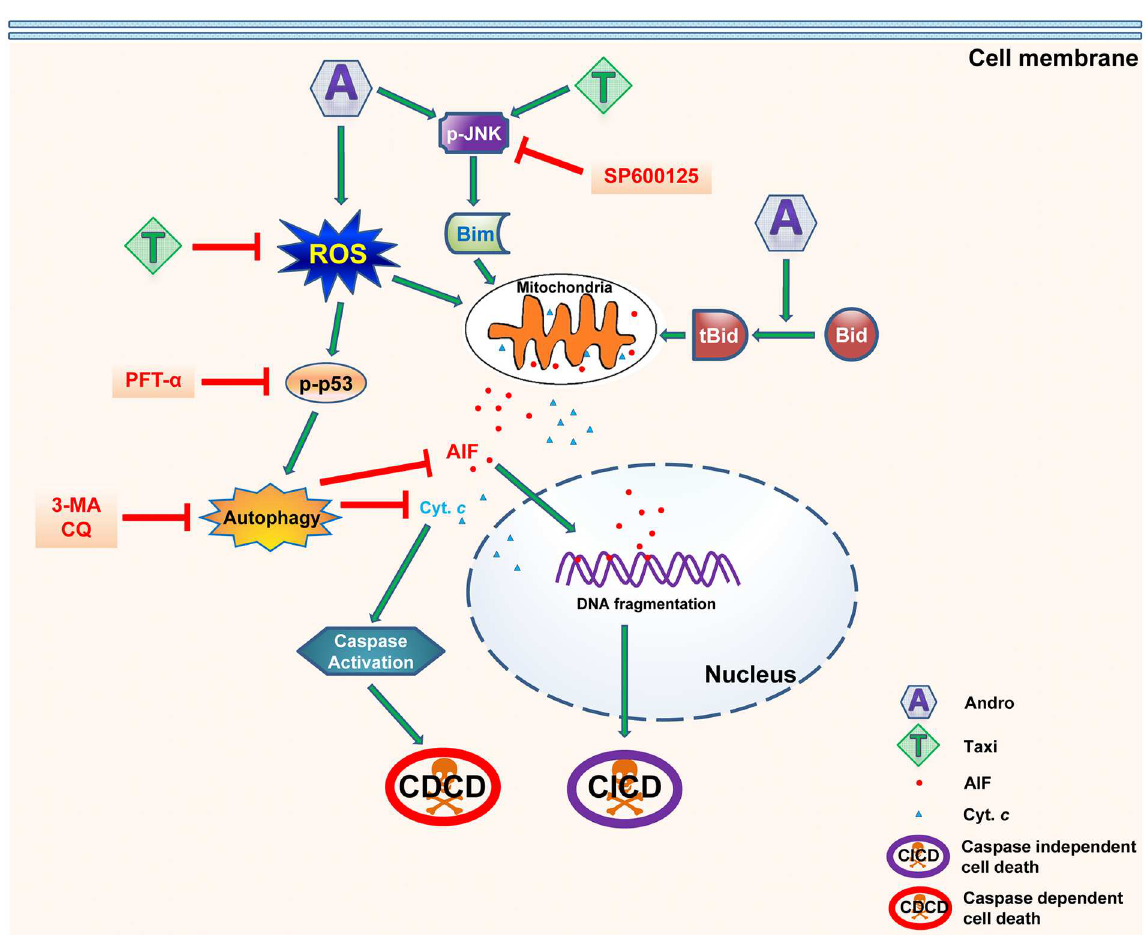
Fig 8. The proposed mechanism for Andro and Taxi induced-cell death in HeLa cells. Andro caused a genotoxicstress in HeLa cells which was associatedwith increasein ROS, MOMP, activationof JNK, p-p53 and apoptosis.Andro also inducedautophagyin HeLa cells which was cytoprotective.The combination of Andro with Taxi decreased autophagyby decreasing ROS and p-p53. The use of the p-p53 inhibitorPFT- α also caused attenuationof autophagy. The combination treatment also increasedthe activationof JNK, the levels of tBid and Bim which increasedfurther the MOMP and the release of AIF and cytochrome c and subsequently caused caspase-3independent and dependentcell death. The use of the JNK inhibitorSP600125reducedthe MMP loss and increasedthe viabilityof HeLa cells